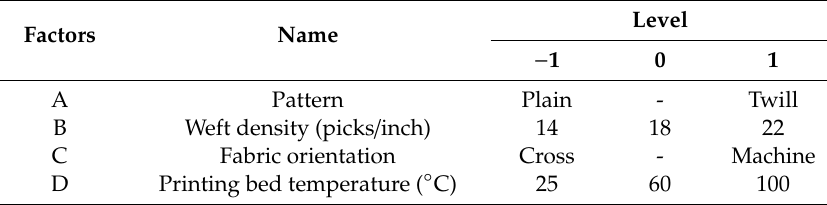
Factors of the statistical design of experiments and their levels for electrical conductivity